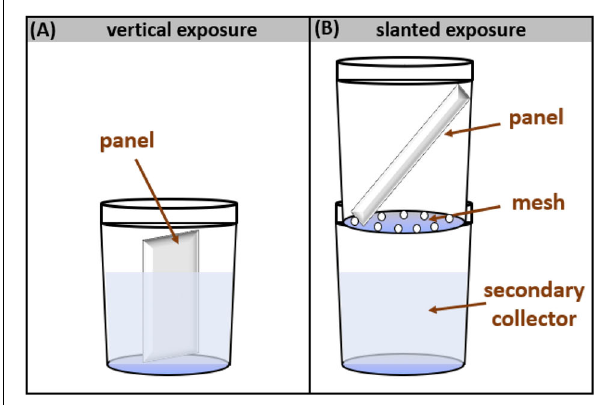
FIGURE 1 | Experimental setups for two weathering scenarios: (A) vertical exposure – consisting of a painted/stained panel vertically positioned in a polypropylene container, (B) slanted exposure – made up of two containers stacked on top of each other and separated by a polypropylene mesh, where the top container contains a painted/stained panel fixed in a slanted position. The vertical exposure is more representative of a surface in more sustained contact with precipitation whereas the slanted exposure is designed to be more representative of the weathering of an outdoor façade. Panels did not extend out of the containers, but rather they were custom cut to fit in the containers, while leaving an overhead space equivalent to 15% of the container